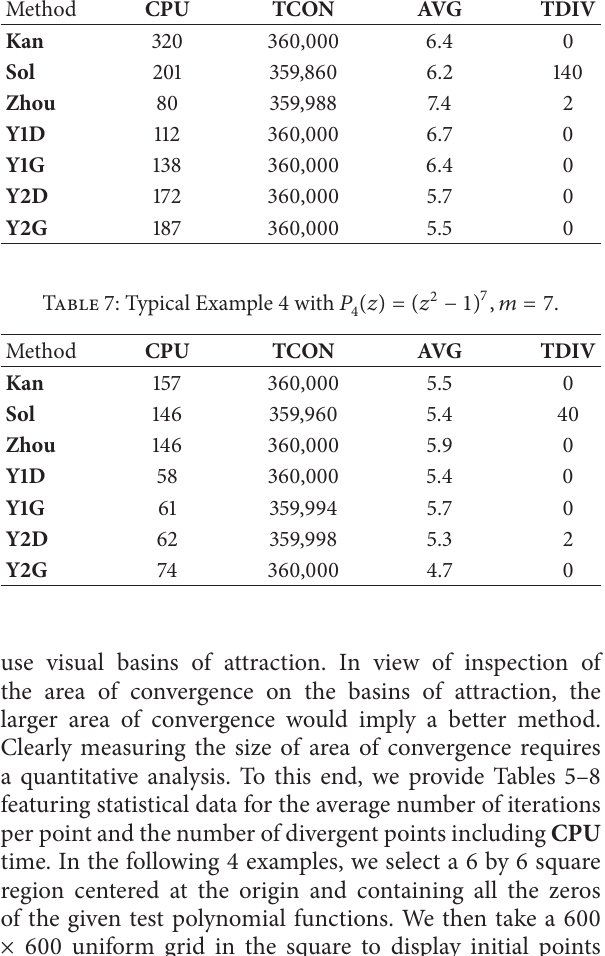
Table 4: Typical Example 1 with 𝑃 1 (𝑧) = (9𝑧 2 + 𝑧 − 7) 2 , 𝑚 = 2 . Methods